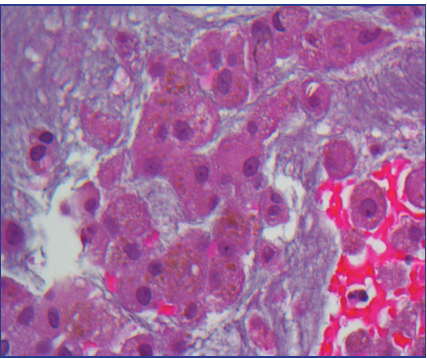
Figure 3: Bronchoscopy image showing the gross carcinoid tumor in the left mainstem bronchus.